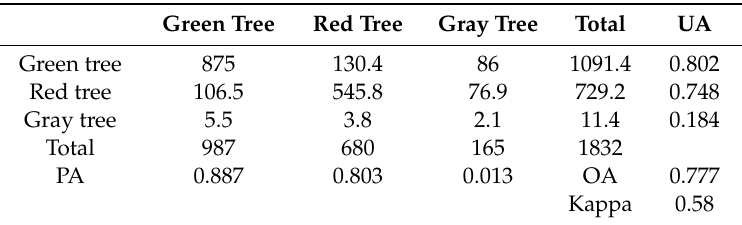
Figure 5. Detail example of the image classification of study areas. ( a ) 1m resolution image based on the pixel method and SVM algorithm; ( b ) 1m resolution image based on the pixel method and RF algorithm; ( c ) 1m resolution image based on the pixel method and C50 algorithm; ( d ) 1m resolution image based on the object method and SVM algorithm; ( e ) 4m resolution image based on the SVM algorithm; ( f ) GF2 true color image; ( g ) UAV image. Table 5. Confusion matrix of GF2 1 m resolution images based on the pixel method and support vector machine (SVM)